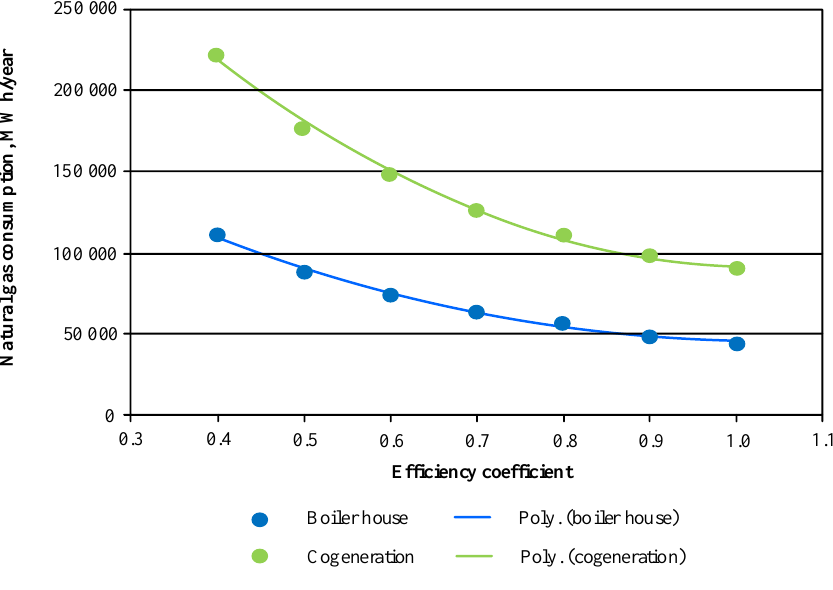
Fig. 12. Natural gas consumption